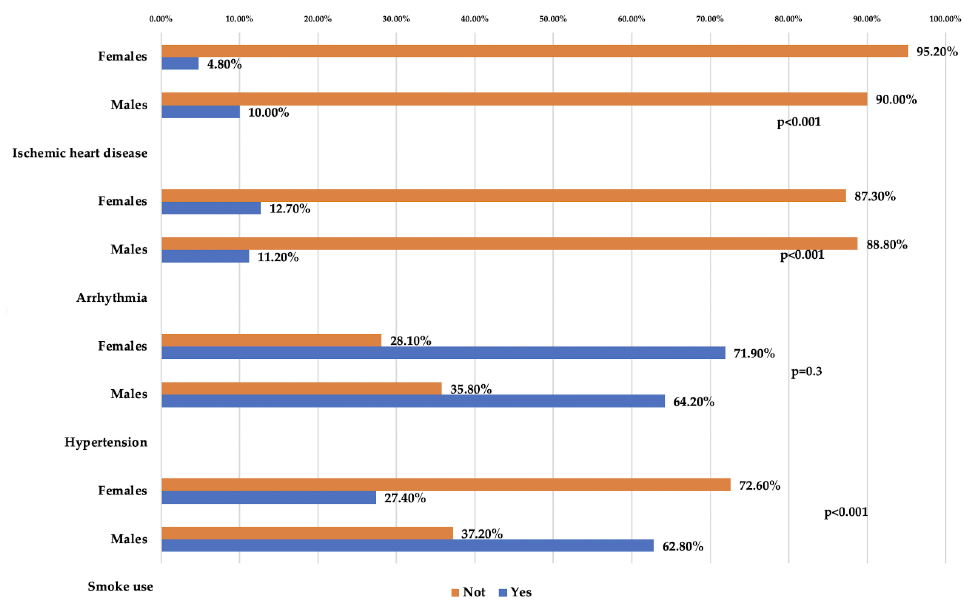
Figure 3. Distribution of comorbidity according to gender. Table 3. Association and risk factors of AAA according to variables